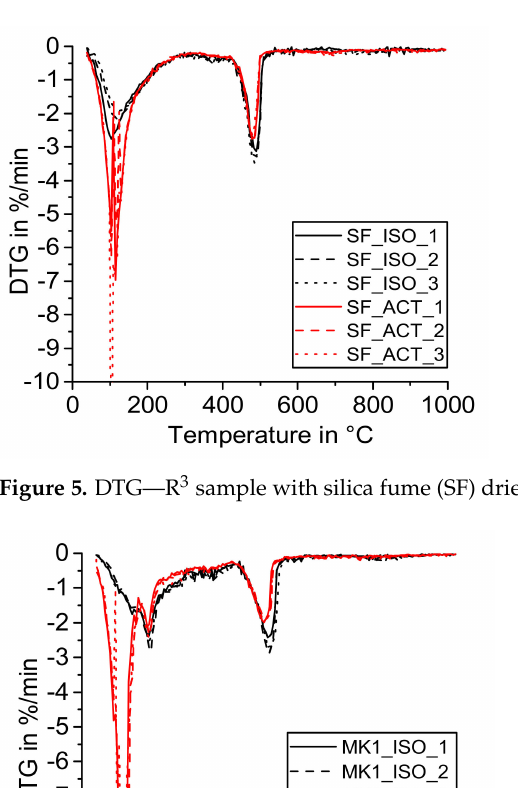
Figure 4. DTG—R 3 sample with mixed calcined clay (MC) dried with isopropanol (ISO) and acetone (ACT).